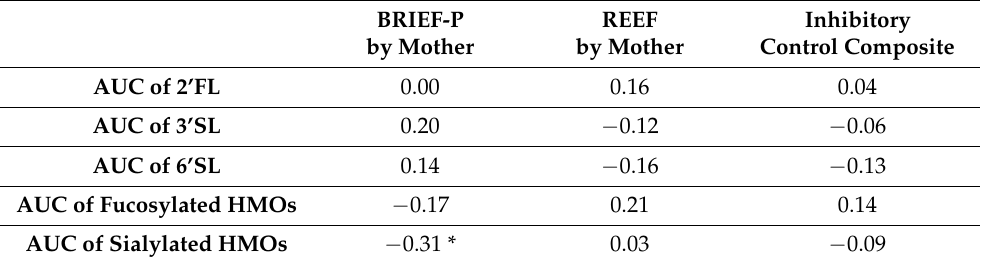
Table 5. Correlations between maternal reports on executive functions, inhibitory control composite, and the AUCs of the HMOs (adjusted for sample-to-sample variability, percentage breastfeeding, and estimated daily intake).